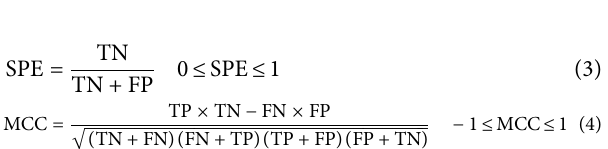
FIGURE 1 | Schematic representation of the methods employed in our